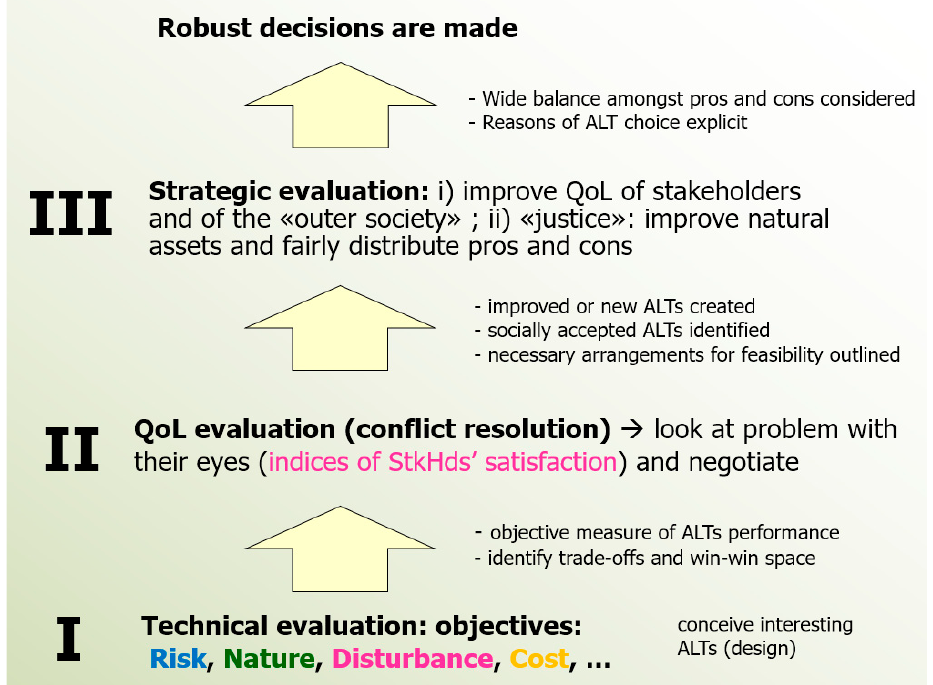
Figure 17. A three-level evaluation framework to support a thorough participatory process.